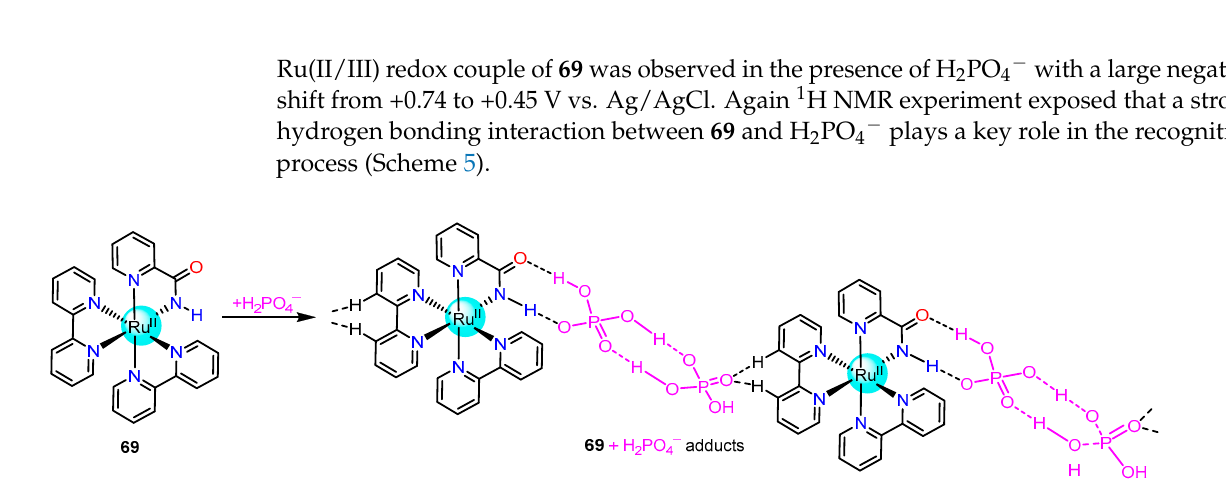
Figure 11. Structures of dipyrrol-based Ru(II) complexes 71 – 73.